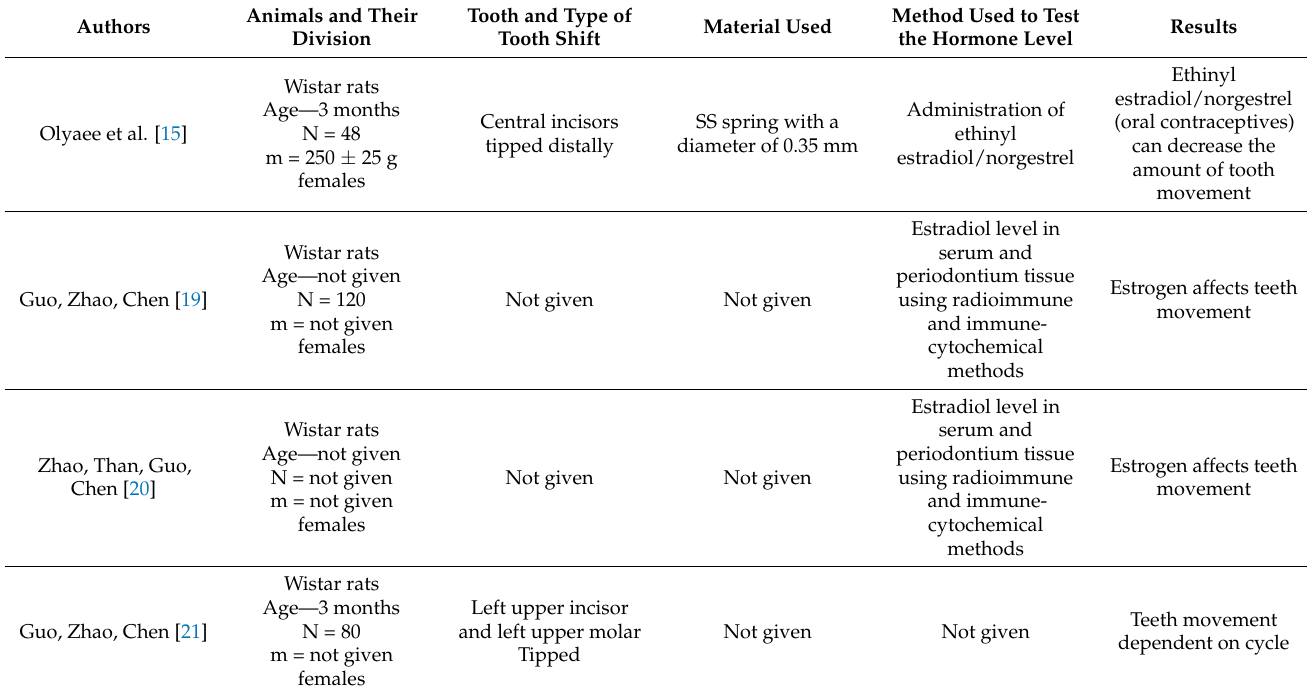
Table 1. List of research methods and results obtained in papers analyzed as part of the